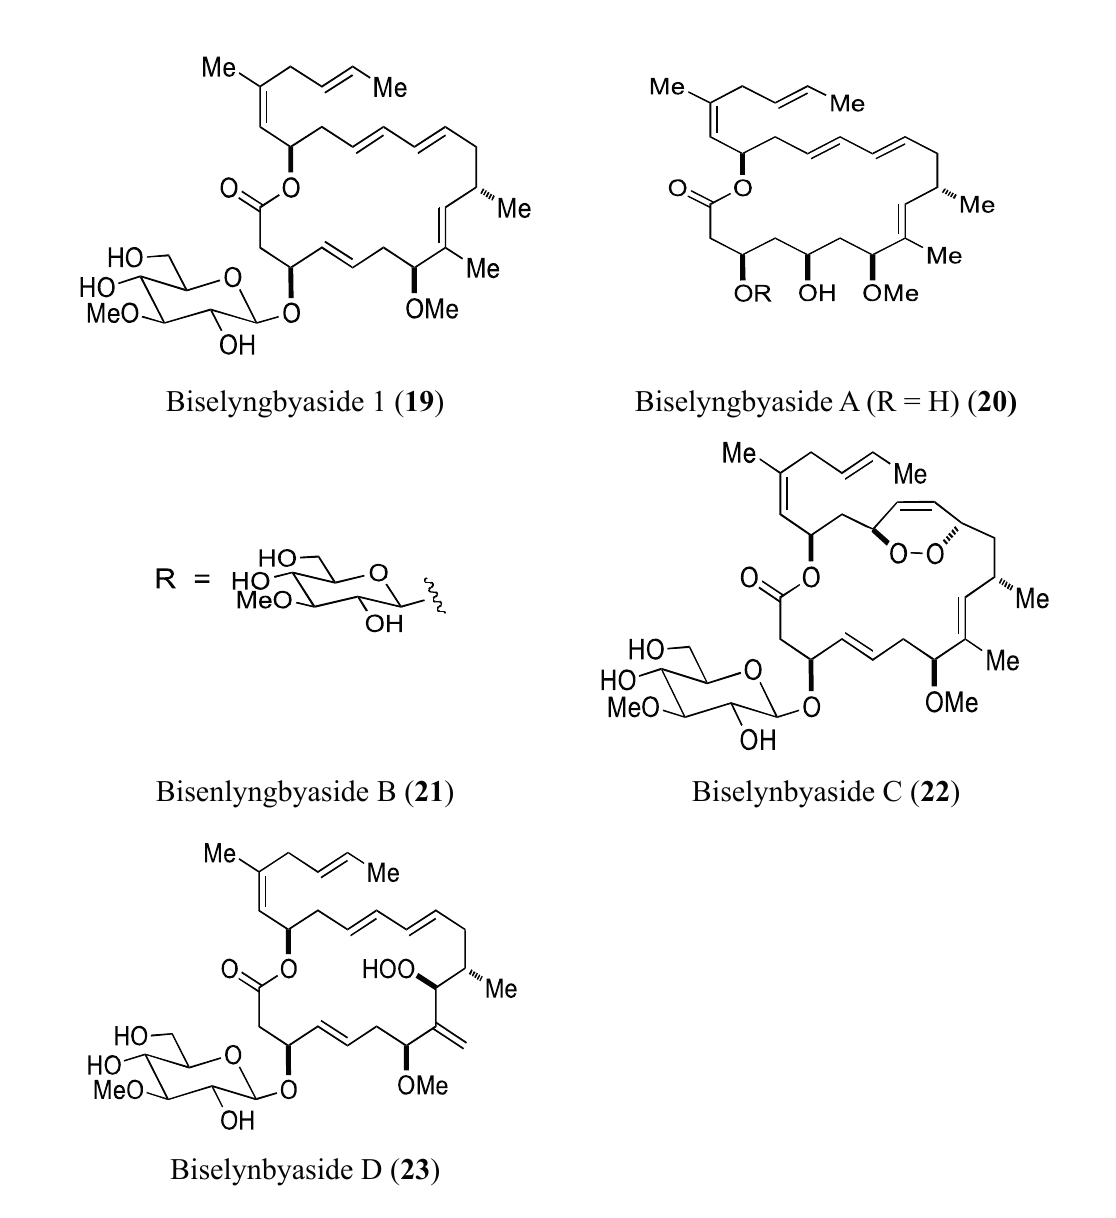
Figure 7. Biselyngbyasides 1, A, B, C,